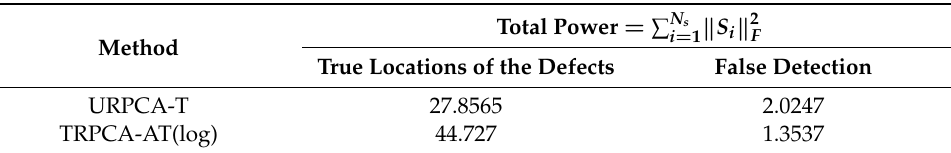
Table 4. Total power of the true defects and false detection for 100 simulations with M = N = 100. Here, the total true power of the defects for all simulations is 100.